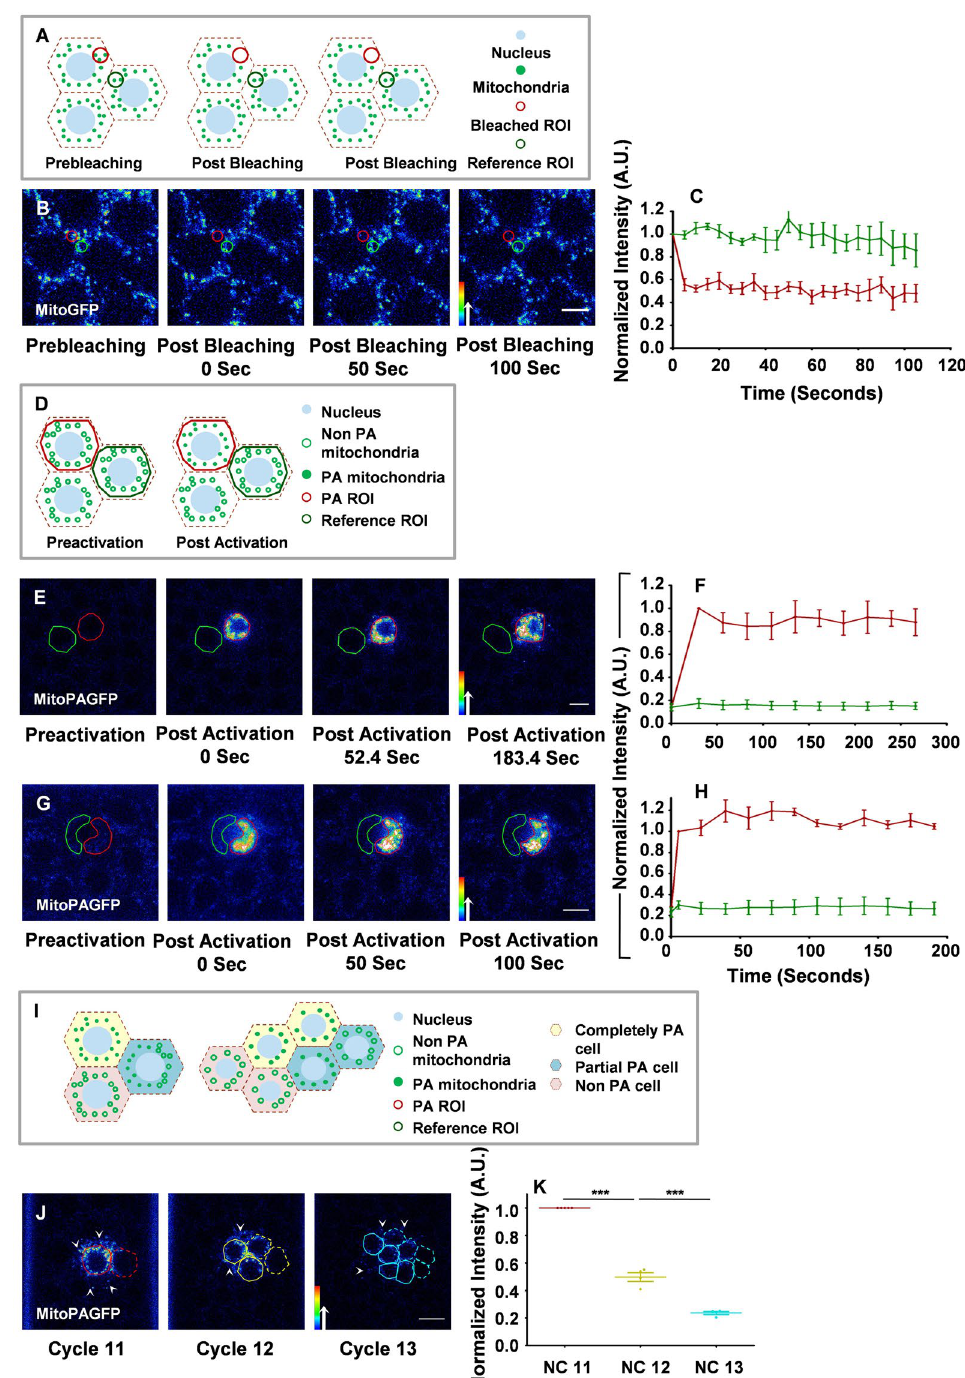
Figure 2. Mitochondria are immobile in the lateral plane in the syncytial Drosophila embryo. ( A – C ) Mito- GFP FLIP shows restricted loss of fluorescence. FLIP schematic with photobleach ROI (red) and reference ROI (green) ( A ). Continuous photobleaching of Mito-GFP is done in an ROI of 4 μ m 2 (red) in interphase of the NC13 ( B ). Fluorescence in the neighbouring syncytial cell ROI (green) does not deplete with time. Normalized mean intensity of bleached (red) and non-bleached (green) ROI is plotted with respect to time ( C ). ( D – H ) Photoactivated mitochondria are restricted in syncytial cells. Non-photoactivated and photoactivated mitochondria are represented as hollow and filled green circles respectively in a schematic of the photoactivation experiment ( D ). Mito-PAGFP is activated in one syncytial cell (red), fluorescence is monitored in neighbouring cell (green), which shows no gain in fluorescence in the given time ( E ) in interphase of NC12. Normalized mean fluorescence intensity of activated (red) and neighbouring (green) syncytial cell is plotted with respect to time ( F ). Mito-PAGFP is activated in a part of syncytial cell (red) and neighbouring region (green) from the same cell is monitored for fluorescence intensity changes ( G ). Neighbouring region does